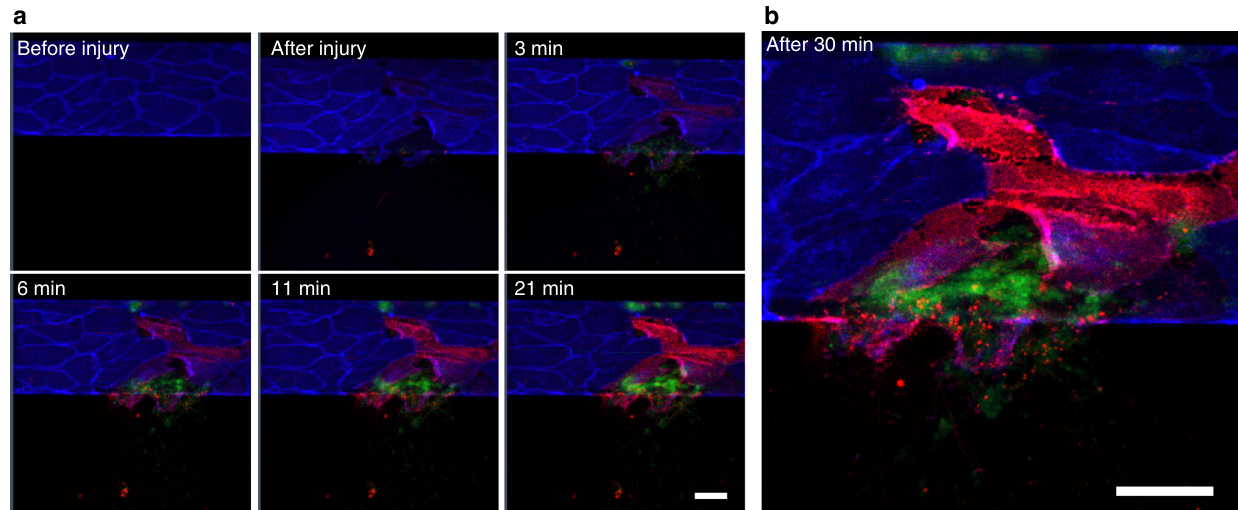
Fig. 4 Annexin V binding reveals rapid exposure of phosphatidylserine (PSer) on endothelial cell surfaces but not on platelets. a Con fl uent endothelial cells before injury show no PSer exposure on their surfaces (top left). Immediately after mechanical injury is induced, the endothelial cells in the strict vicinity of the wound exhibit PSer exposure, as measured with annexin V binding (red) in a time-dependent manner while losing their plasma membrane staining over the time course (blue). In contrast, platelets (green) adhered at the injury site did not exhibit PSer exposure. b Thirty minutes after the injury was induced and hemostasis was achieved, the majority of the platelet aggregates did not exhibit signi fi cant amounts of PSer exposure, in contrast with endothelial cells at the wound site, which exhibit signi fi cant PSer exposure. All scale bars = 50 µ m